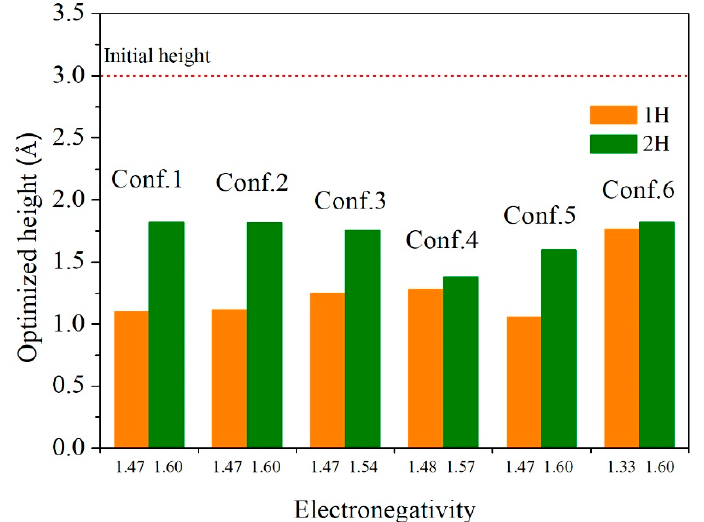
Figure 9. The optimized height of the two hydrogen atoms for the atomic hydrogen desorption on TiZrVMoNb hydride (110) surface in the six configurations with an initial height of 3.0 Å. The parallel axis indicates the electronegativity of the nearest-neighboring metal atoms for the top site or average electronegativity of the two coordinated metal atoms for the bridge site.